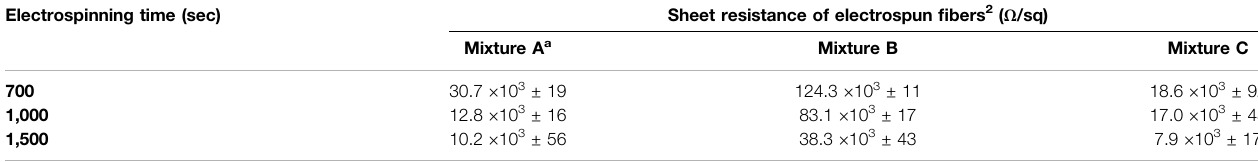
a Errors are given from the range and the correction factor used for each measurement and these were averaged for the fi ve sampled areas.